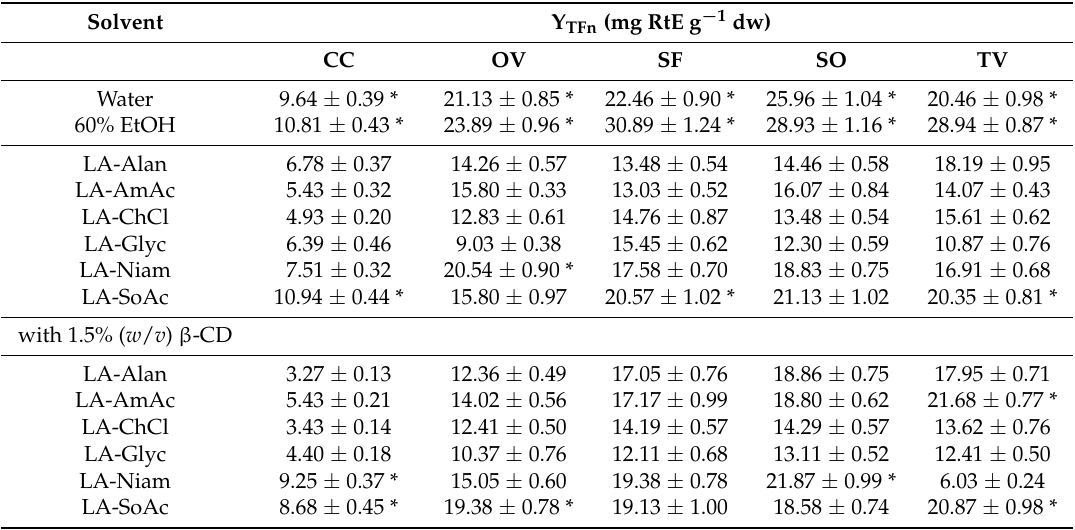
Table 4. Y TFn (mg CAE g − 1 dw) of the extracts obtained using DES and β -CD/DES combination. Asterisk denotes statistically higher value ( p <